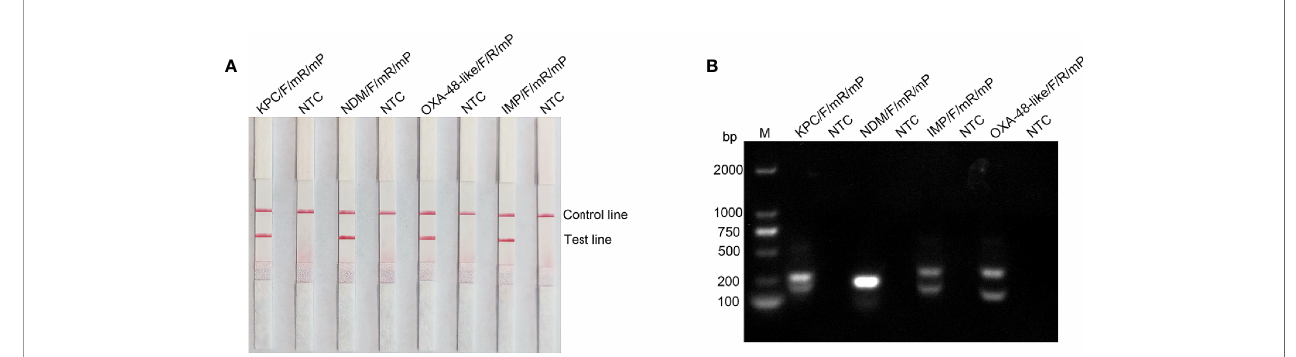
FIGURE 3 | Testing the modi fi ed primer-probe set using the RPA-LFS reaction. (A) Results of the LFS detection of the RPA ampli fi cation products. The name of each primer-probe set is labeled above the corresponding band. (B) RPA ampli fi cation products were analyzed using agarose gel electrophoresis. The name of each